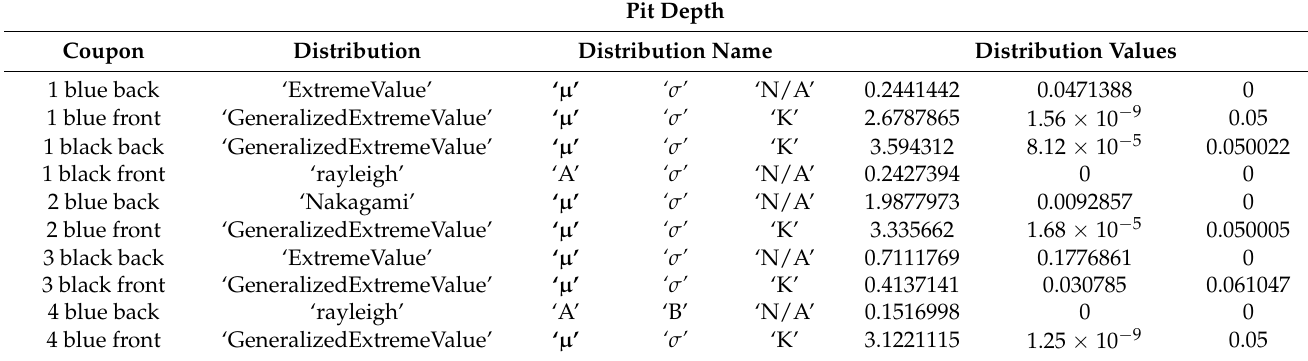
Table 7. Pit depth statistical fit. Pit